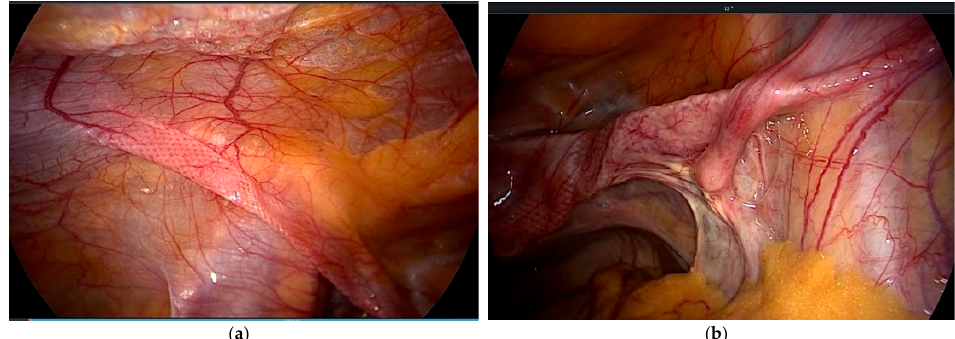
Figure 3. ( a ) Mesh arms extraperitoneal on the left; ( b ) crossing vessels and the psoas muscle on the right side.